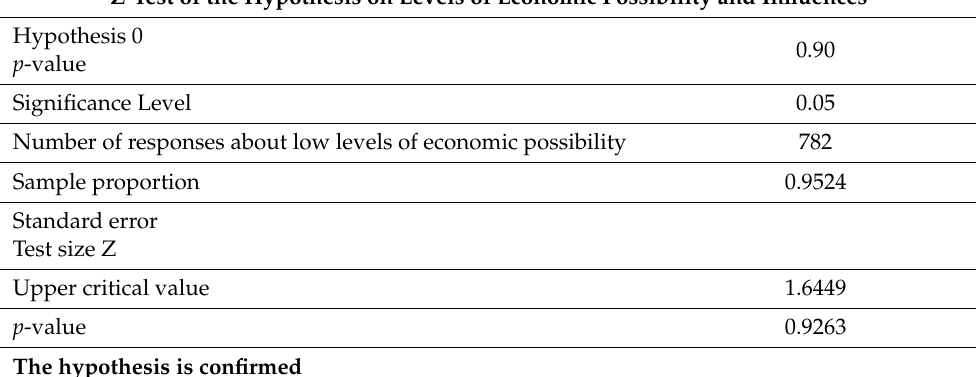
Table 4. ‘Low levels of fear of the COVID-19 infection and its influence on consumption of dietary supplements’ Hypothesis